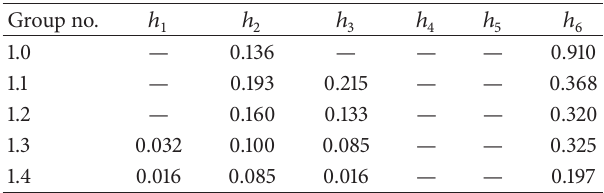
Table2:Averagevaluesoftheimperfections’performancemeasures (mm).